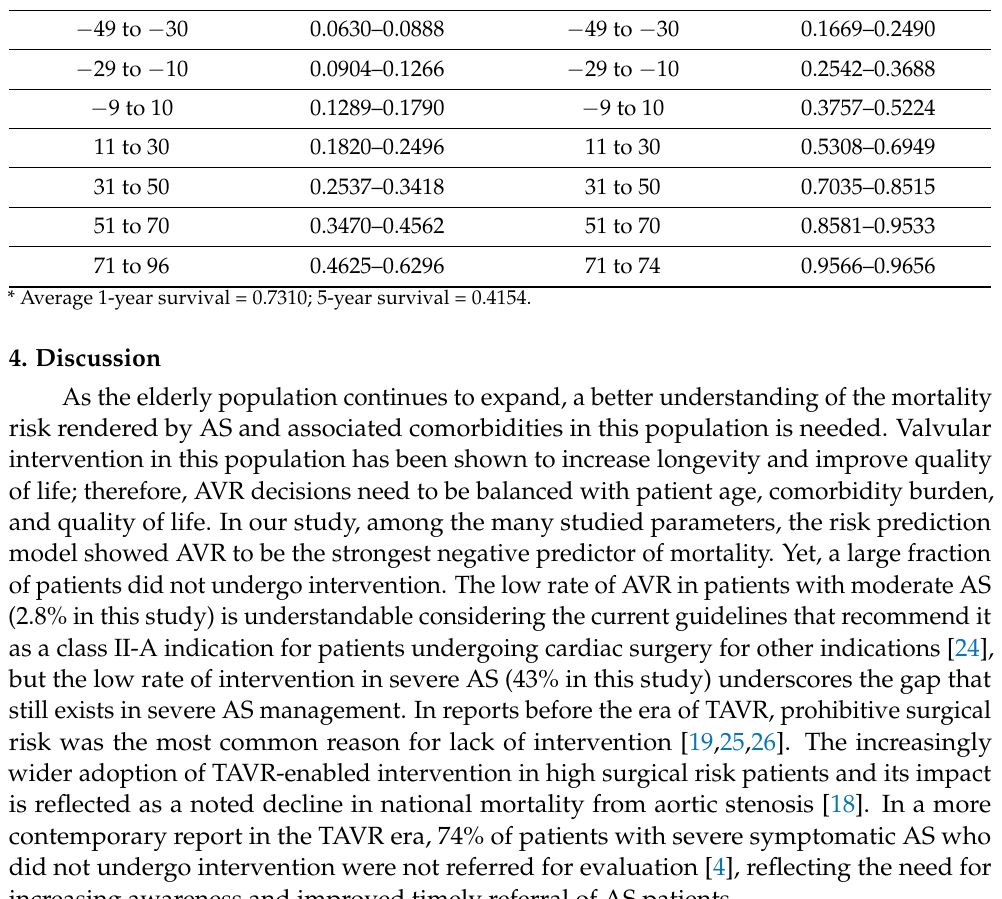
Table 4. Risk estimates of 1- and 5-year mortality for AS patients with 1-year and 5-year follow-up *. Patients with 1-Year Follow-up Patients with 5-Year Follow-up Estimate Risk of Estimate Risk of Total Score Total Score 5-Year Mortality 1-Year Mortality − 111 to −